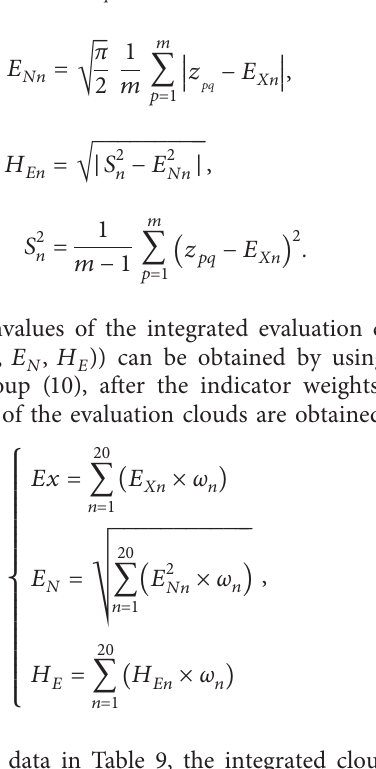
Figure 5. From the simulation results, the integrated cloud map of section 8 is between “2A” and “A” and is more inclined to “2A.”